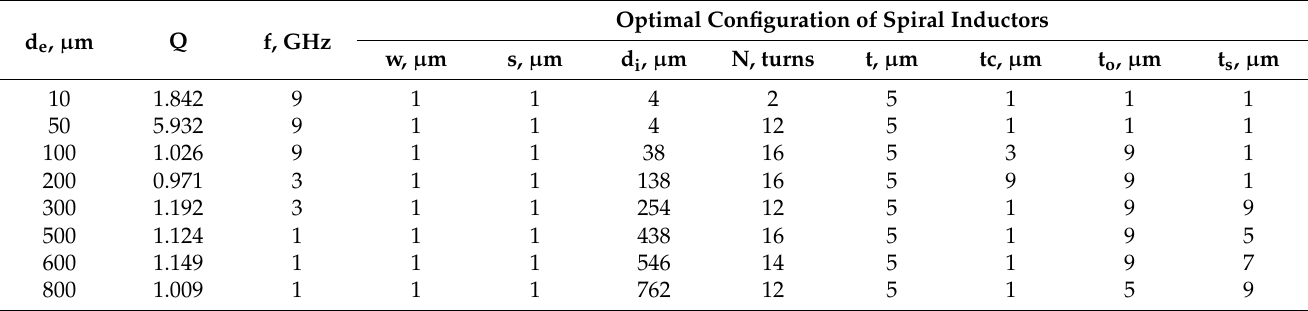
Table 4. The optimal configuration for maximal quality factor in 1–10 GHz frequency